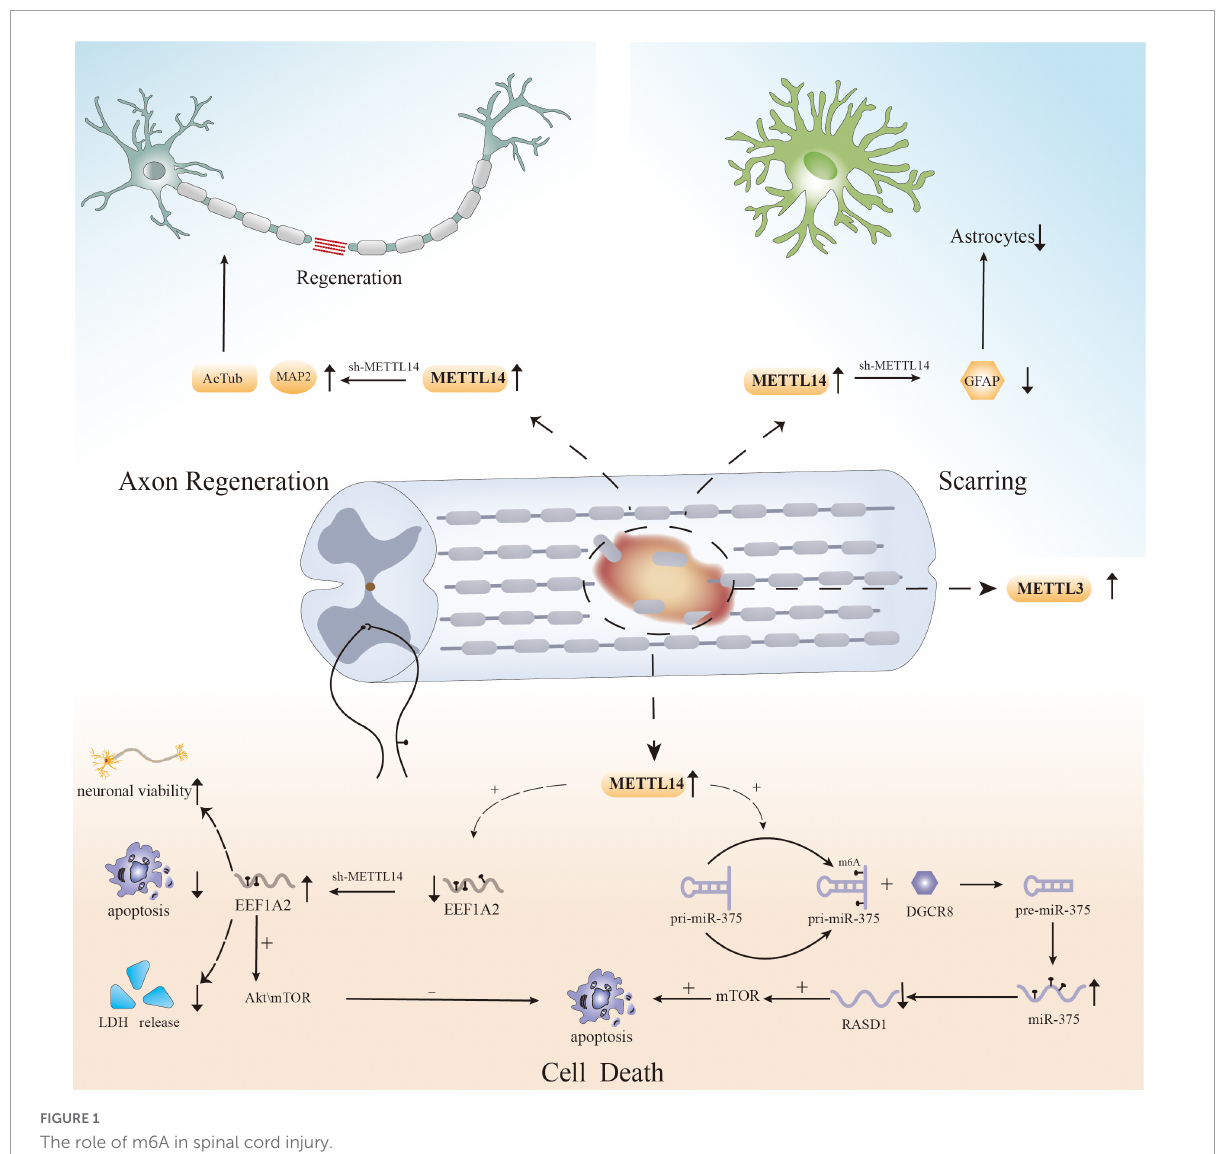
FIGURE1 The role of m6A in spinal cord